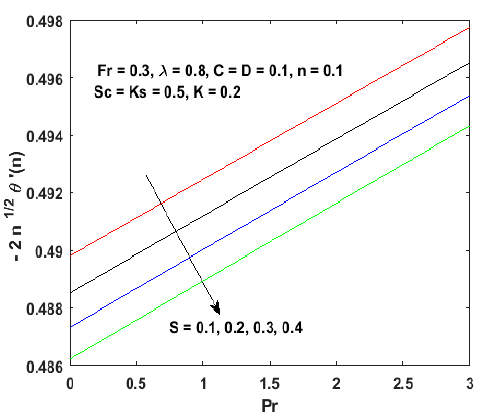
Figure 13. E ff ect of Pr and S on − 2 n 1/2 θ (cid:48) ( n ) Figure 13. Effect of Pr and S on Figure 13. Effect of Pr and S on